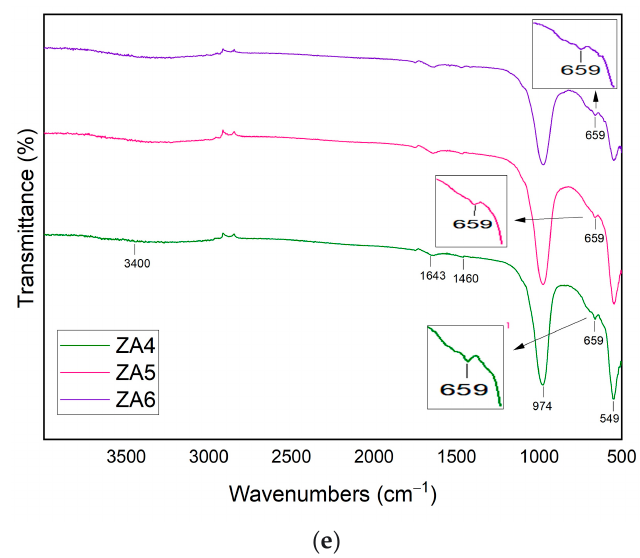
Figure 4. XRD patterns of synthesized zeolites ZA4, ZA5 and ZA6 ( a ), * sodalite and ◦ LTA. SEM micrographs of ( b ) ZA4, ( c ) ZA5 and ( d ) ZA6. FTIR spectra for ZA4, ZA5 and ZA6 ( e ).